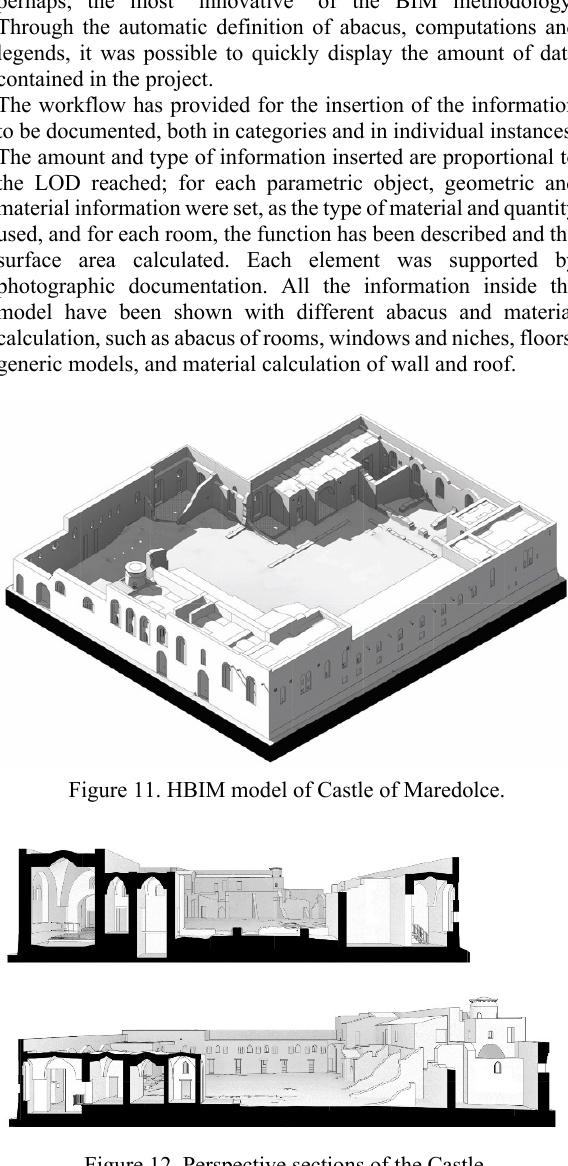
Figure 12. Perspective sections of the